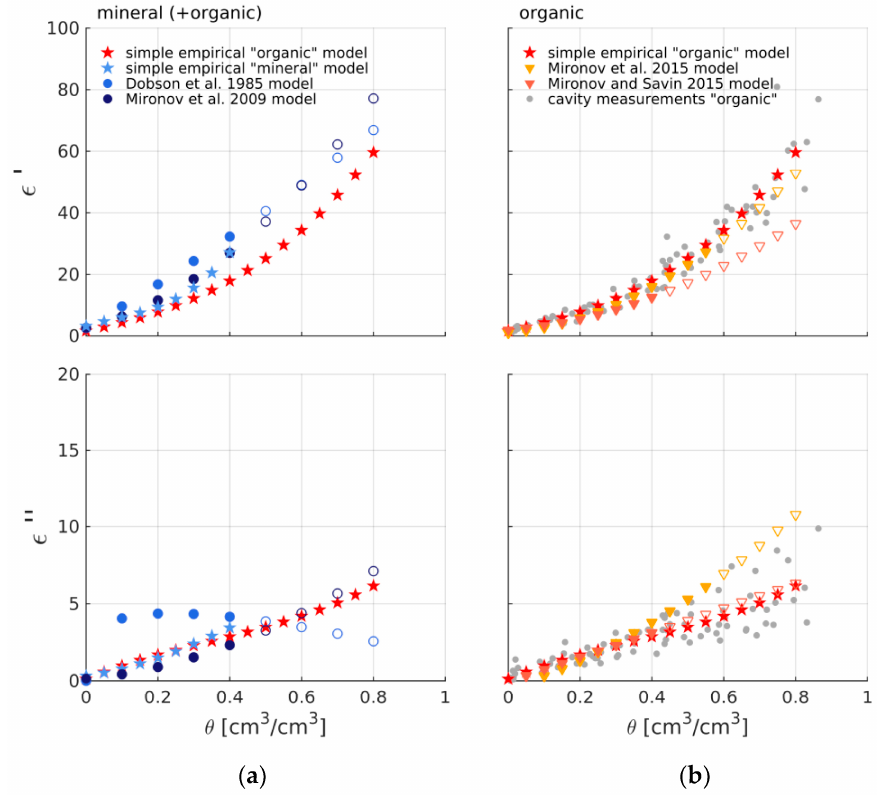
Figure 5. Measured and modeled relative permittivity data as a function of soil moisture at room temperature, real ε′ (top panel) and imaginary ε″ (bottom panel) parts. ( a ) Simple empirical models based on 3rd order polynomial fits through the collectivity of sandy mineral as well as organic samples (light blue and red stars, respectively), Dobson and Mironov mineral model outputs (blue and dark blue circles, respectively) using input specificed in Table 2; ( b ) resonant cavity measurements acquired from all organic samples after filtering (grey dots) including the empirical model for organic substrates (red stars), now together with curves fit through output of the Mironov et al. [30] and Mironov and Savin [31] models for organic soil layers (orange and salmon triangles, respectively) adopted from literature. Filled icons denote the range where data was available for ( a ) model calibration of the Dobson and Mironov mineral models or ( b ) for curve fitting to the data presented in Mironov et al. [30] and Mironov and Savin [31].